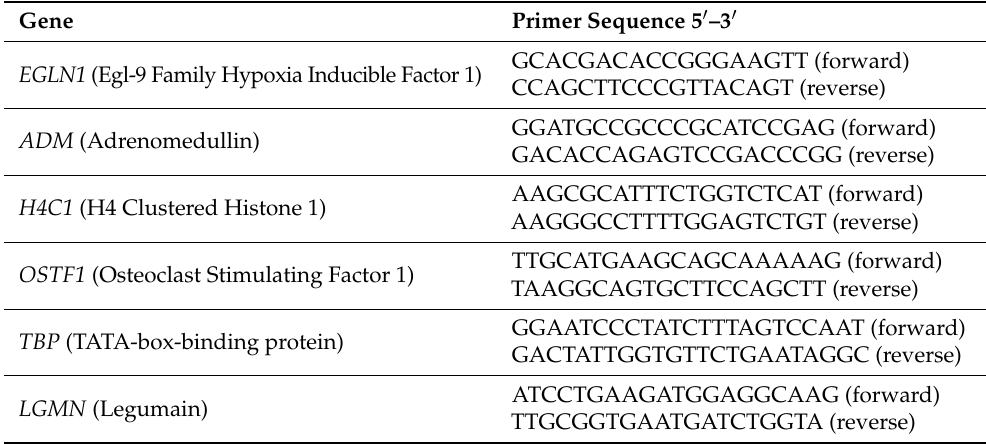
Table 1. Primer sequences for Real-time